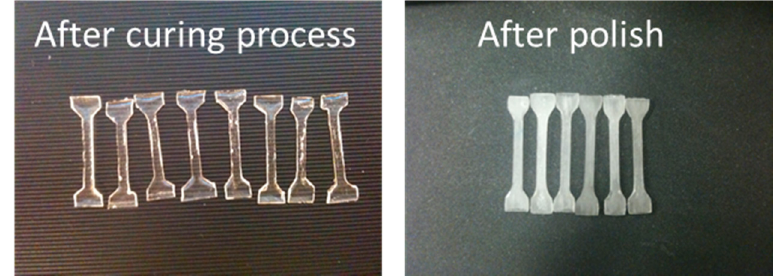
Figure 2. Dog-bone shaped samples preparation process.